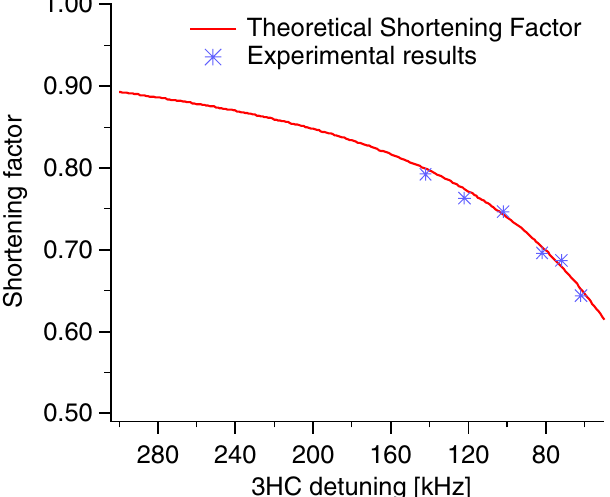
FIG. 20. (Color) Theoretical bunch shortening factor in function of the 3HC detuning.